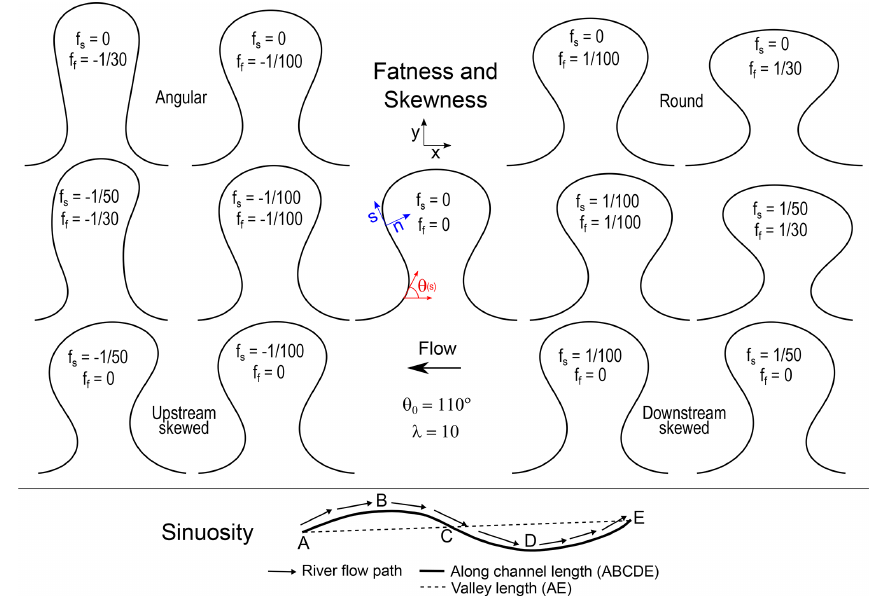
Figure 4. Meander bend parameter definitions. The top panel shows the effect of the fatness and skewness coefficients in a Kinoshita meander curve (Eq. 1) and the bottom panel shows the definition of sinuosity.